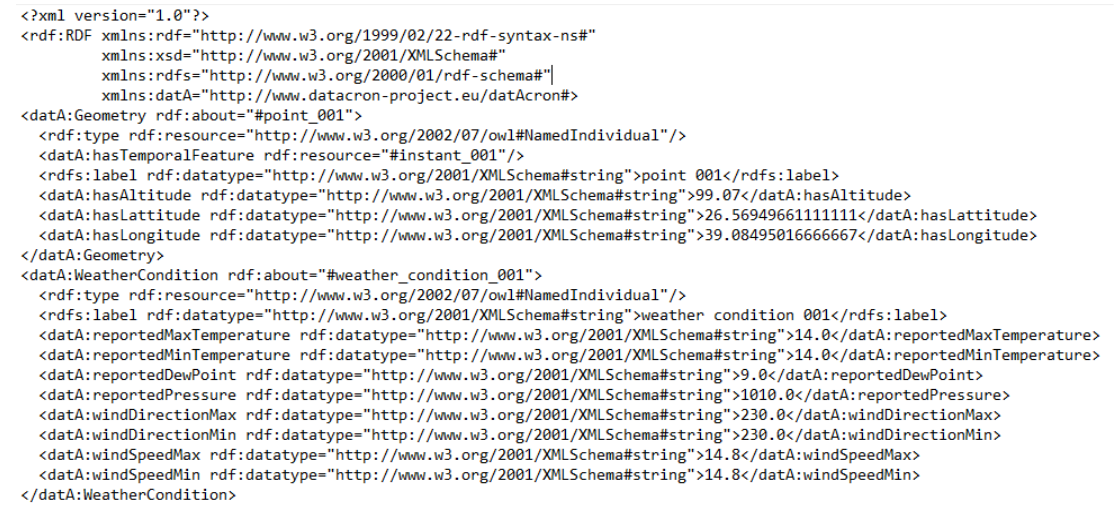
Figure 14. Interactive visualization of a trajectory. ( a ) Visualization of information contained in each point of the trajectory; ( b ) visualization of the data contained in a stop area of the trajectory.